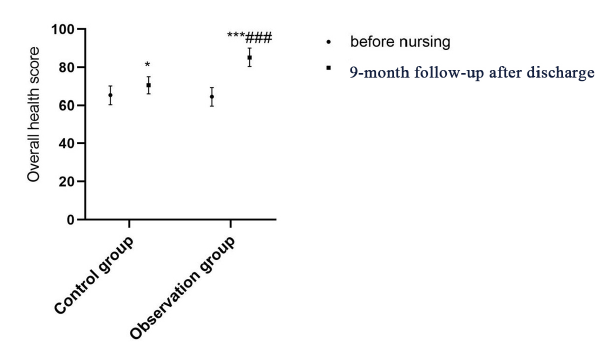
Fig. 6 - Comparison of overall health score between the two groups before and after continuing care. Compared with on admission within the same group, *P<0.05, ***P<0.001; compared with the control group after continuing care, ###